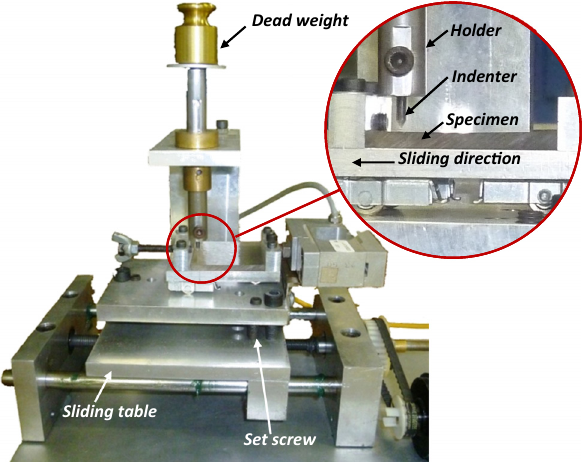
Figure 1: Experimental set - up used for single scratch tests ( SST )